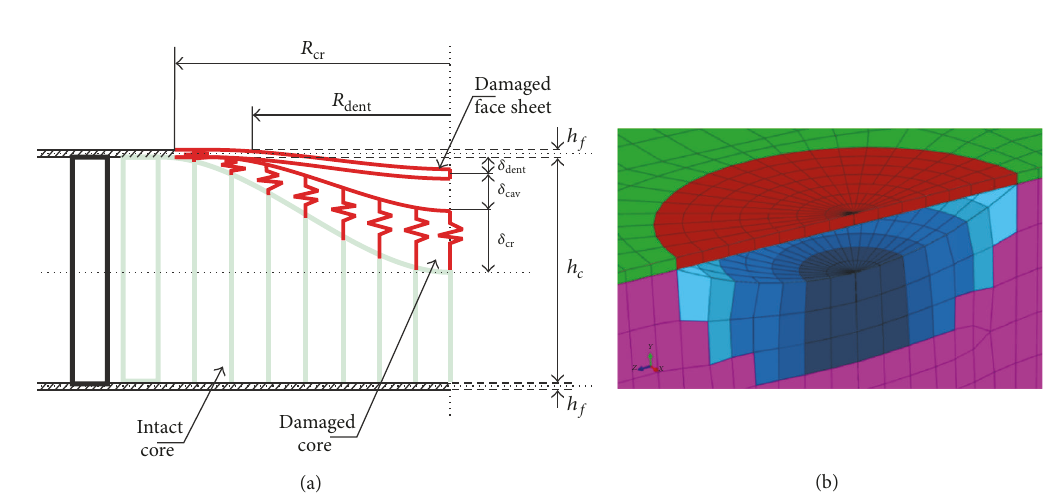
Figure 7: Impact-damaged region: (a) key geometrical parameters [86]; and (b) finite element